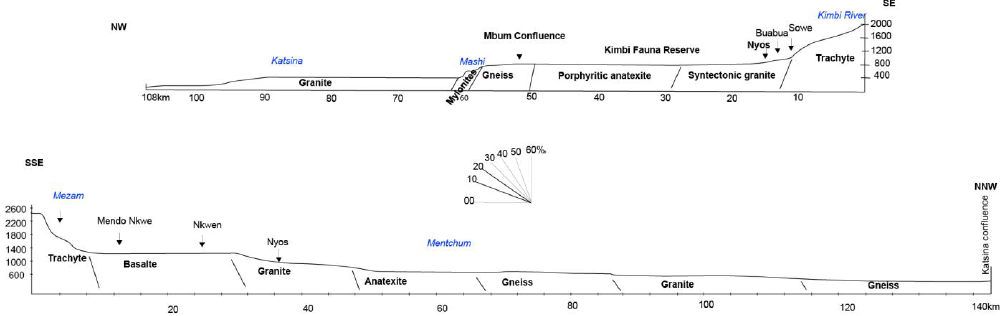
Figure 14. Katsina and Menchum rivers longitudinal profiles. Two main features are recognizable: highland areas > 2000 m a.s.l. located within large volcanic units; and low altitude areas < 1200 m a.s.l. with crystalline bedrock compartmentalized by faults